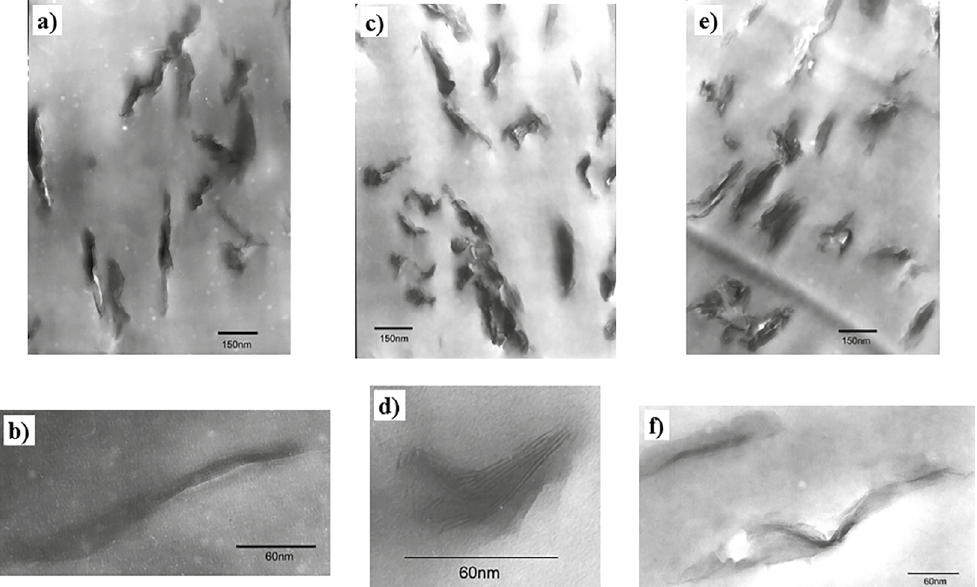
Figure 1. TEM micrographs of PET nanocomposites containing 5 wt% of organoclay. (a-b) PET-5M, (c-d) PET-5M5I, (e-f)